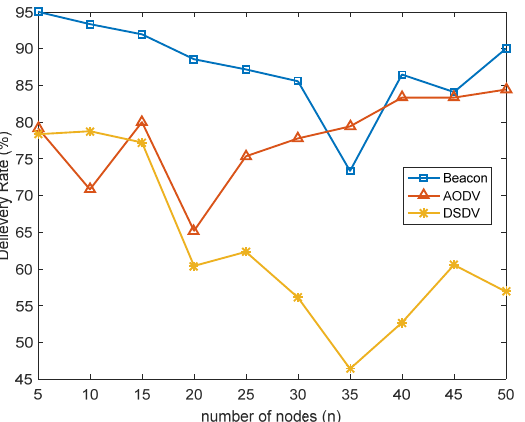
Figure 6. Delivery ratios of beacon routing protocol and AODV, DSDV protocols.